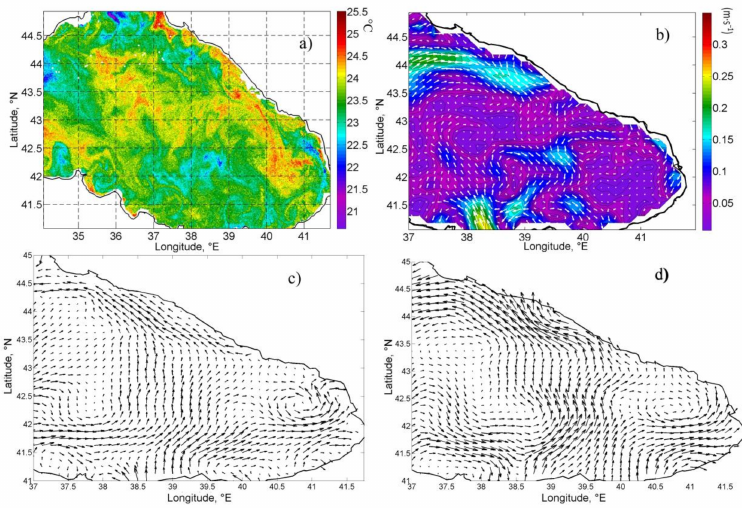
Figure 5. AVHHR SST at 26 June 2007 19:12 ( a ); Difference between currents calculated from IR imagery and altimetry data ( b ); surface currents calculated for 27 June 2007 from altimetry data ( c ) and IR images ( d